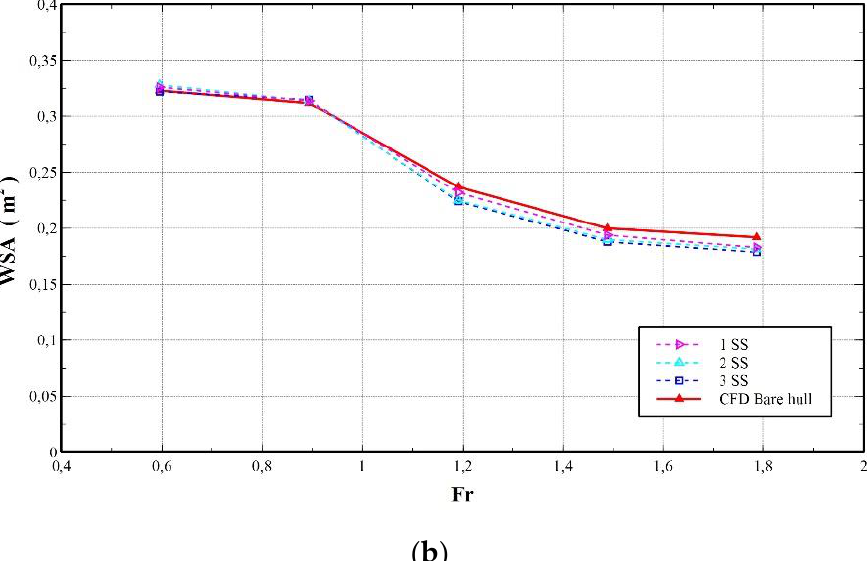
Figure 10. The relationship of resistance components ( a ) Frictional resistance; ( b ) WSA for the parameter numbers of spray strips.